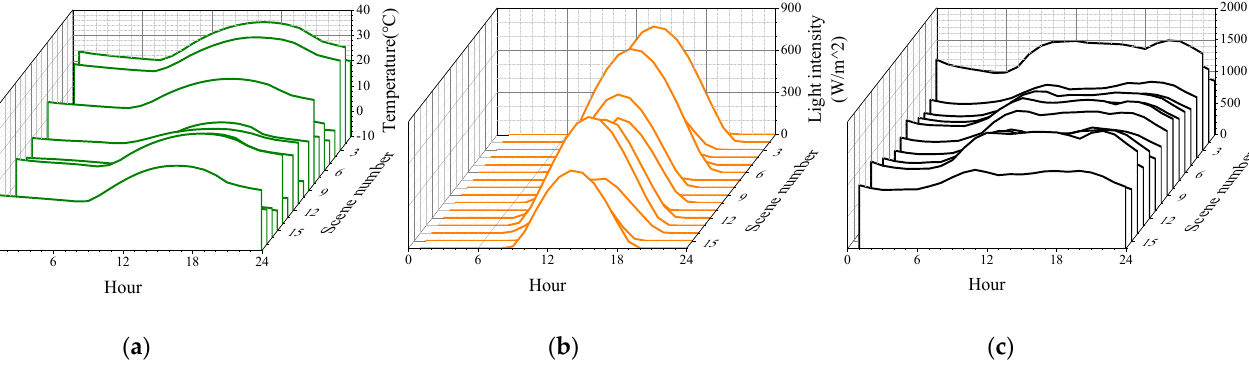
Table 1. Probability of clustering